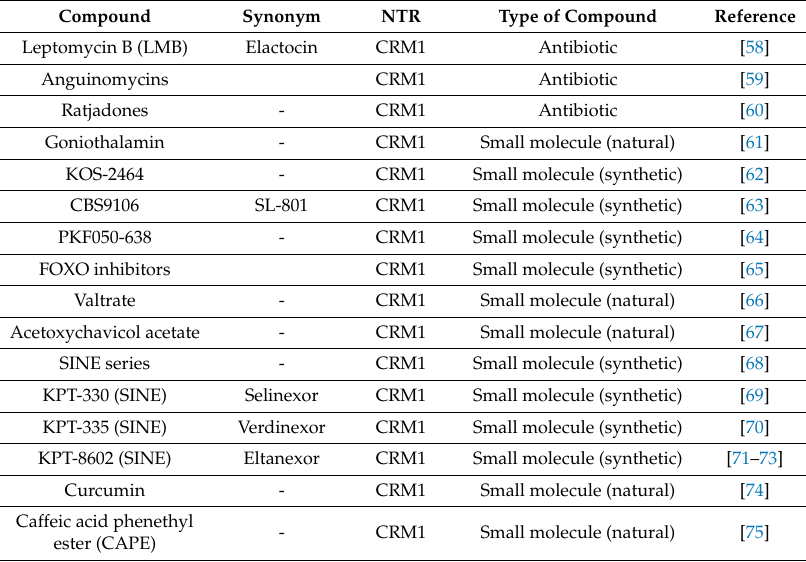
Table 1. Selected protein nuclear export